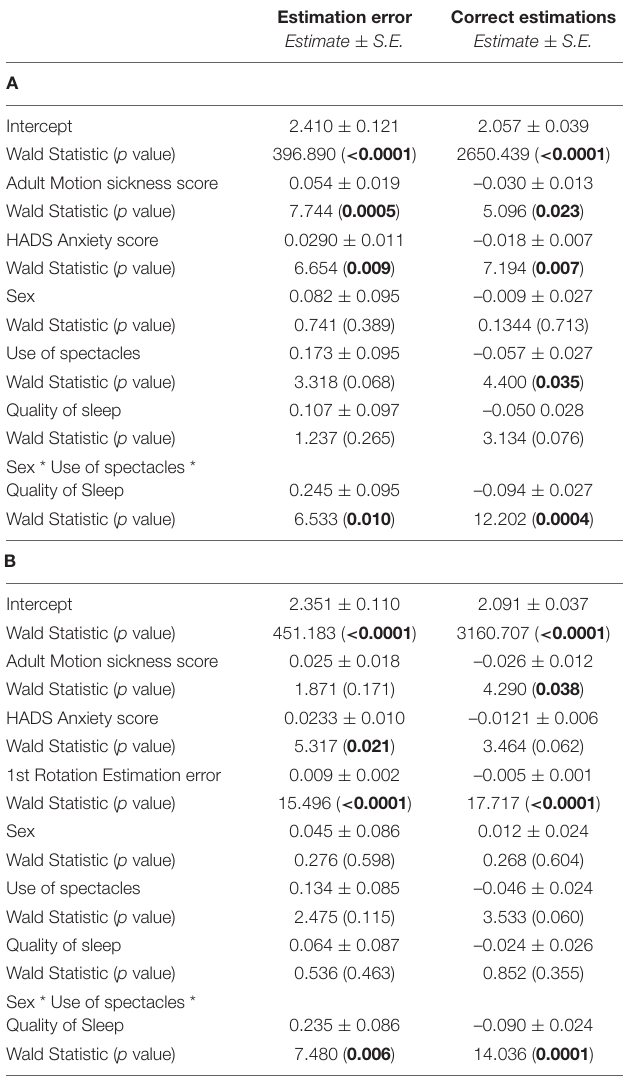
TABLE 4 | Coefficient estimates and standard error (S.E.) of the estimates are described with Wald statistic and p values for the average estimation error and the total correct estimations without including the first rotation estimation error (A) and including it (B) . Estimation error Correct estimations Estimate ± S.E. Estimate ±